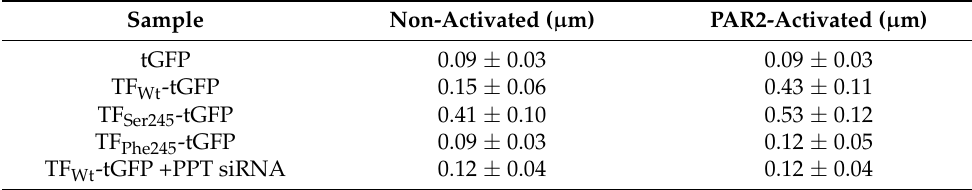
Table 3. Estimation of TF aggregate